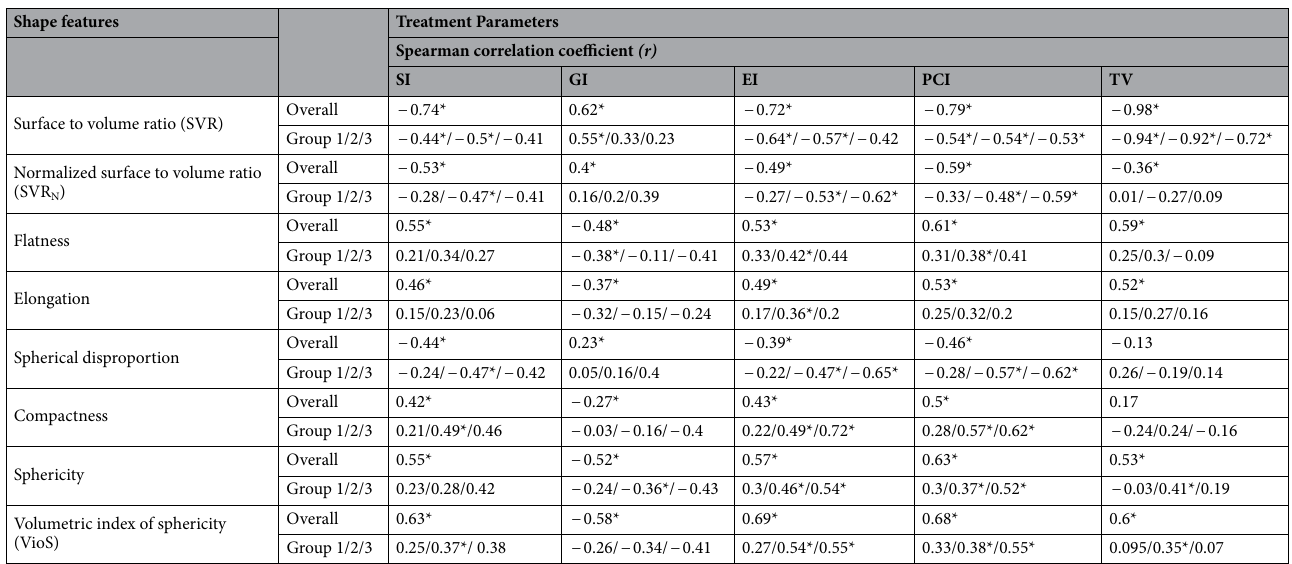
Table 2. Spearman correlation analysis of all tumor models (overall) and subgroups (Group 1/2/3) for evaluating the relationship of each shape feature with dose planning indices (* P <